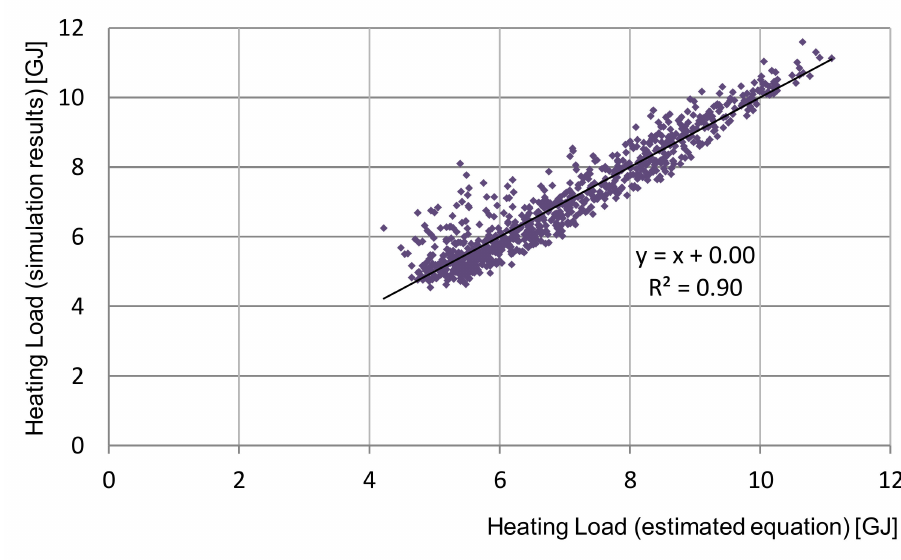
Figure 2. Simulation and estimated equation results of annual heating load (842 points).